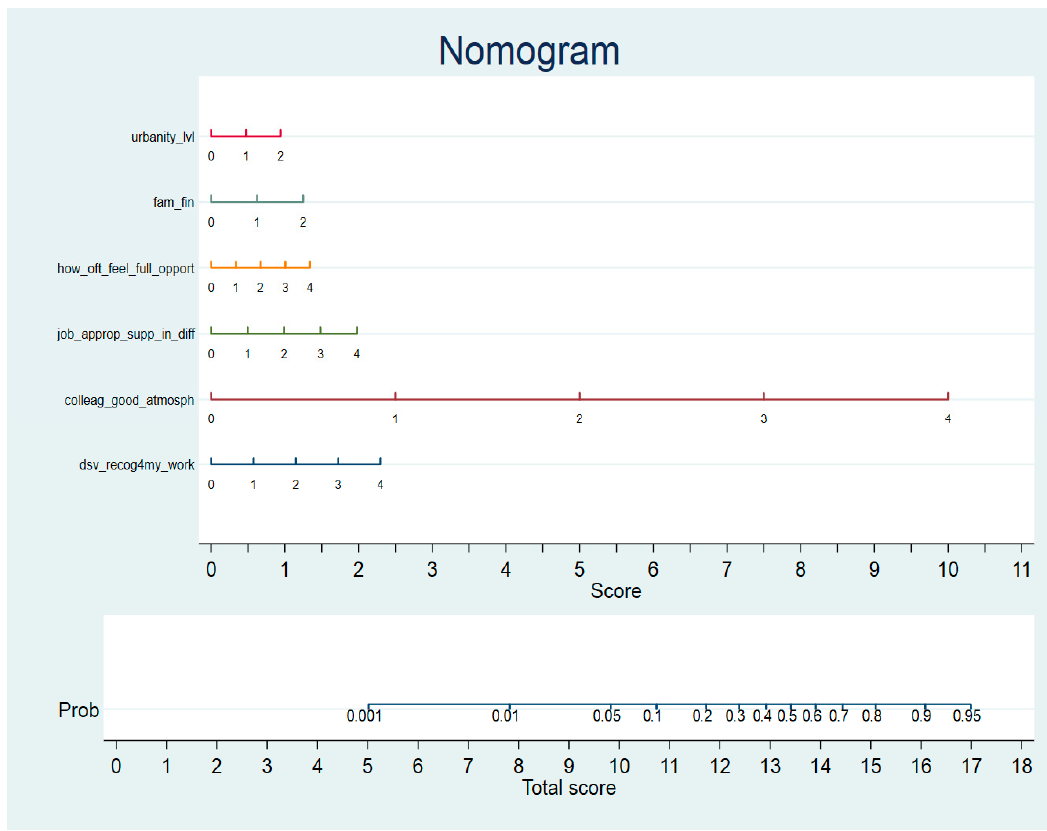
Figure 4. Full job satisfaction prediction nomogram for a regional model (Table 3, scenario c), corresponding to the third Romanian historical region being analyzed (OMD).